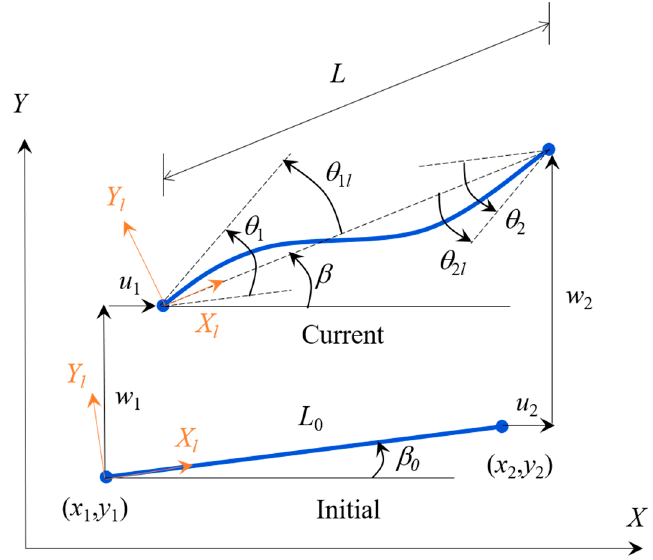
Figure 2. Initial and current con fi guration of a beam element.